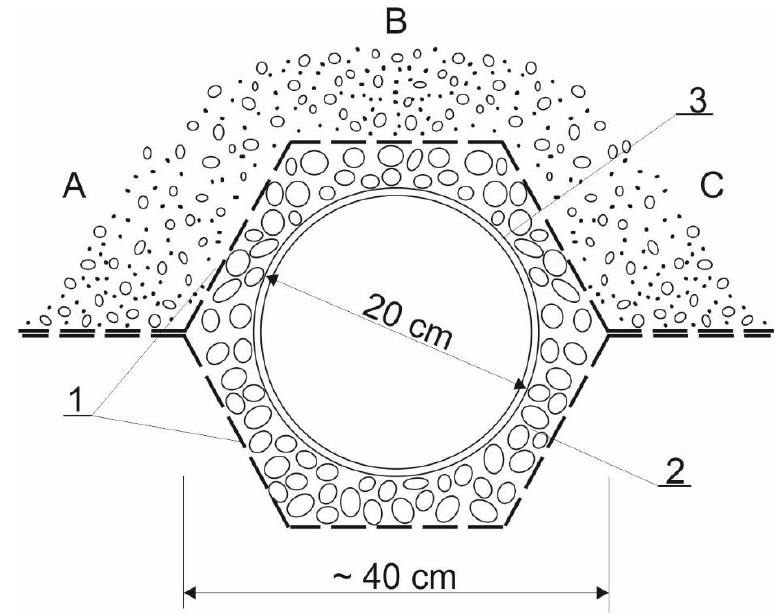
Figure 5. Drainage of the Piaski-Szczygliczka Dam: 1. Nonwoven geotextile WD-3; 2. Gravel; 3. Slotted pipe; A, B and C – nonwoven geotextile and soils sampling zones.